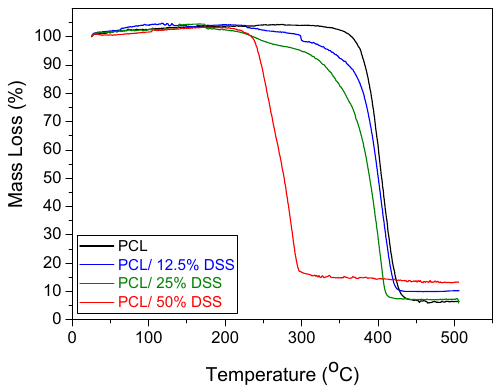
Figure 4. Thermogravimetric analysis of the studied samples: pure PCL (black line), PCL/12.5%DSS (blue line), PCL/25%DSS (green line) and PCL/50%DSS (red line) fibrous mats.